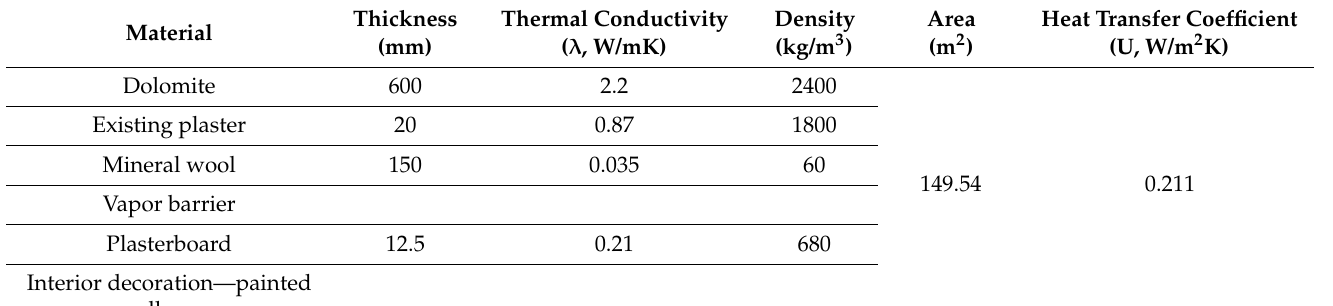
Table 2. Facade construction after retrofit in 2015: Type 2.